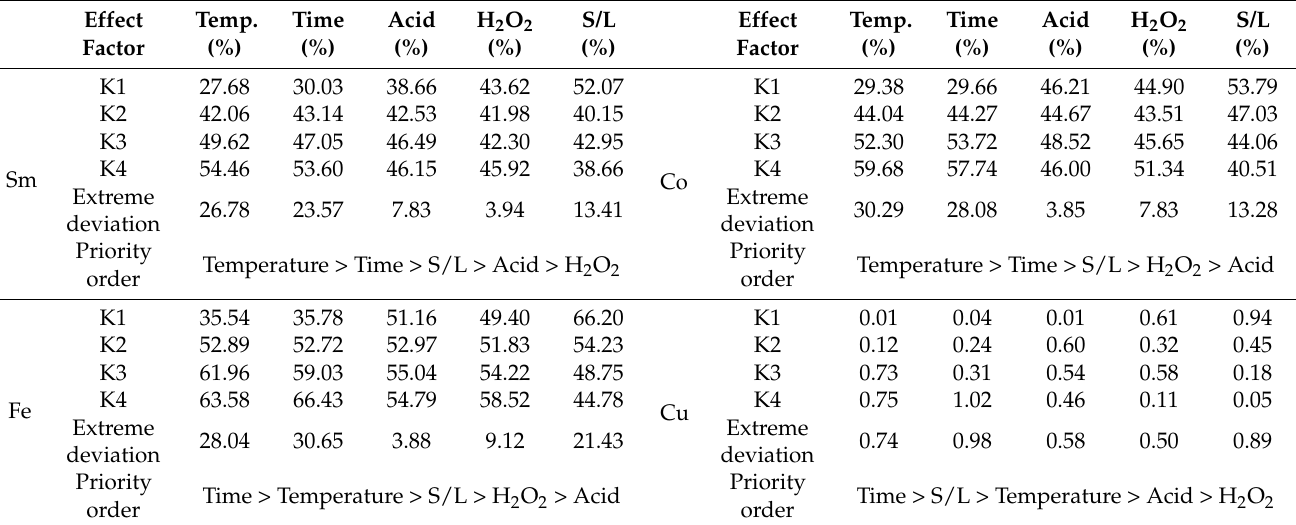
Table 6. Factor response table for malic